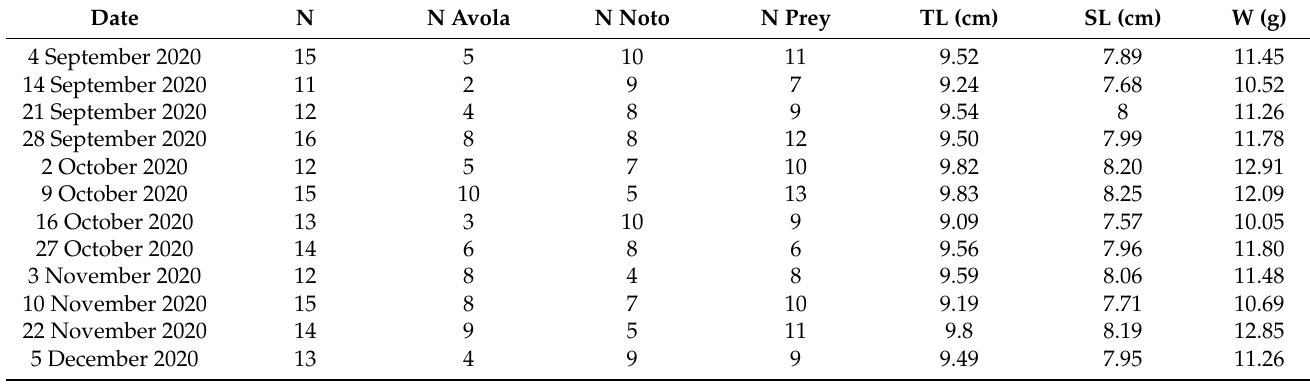
Table 1. Means of the basic measurements per sampling day for Gobius paganellus ; N = total number of specimens; N Avola = specimens collected at Avola; N Noto = specimens collected at Noto; N Prey = specimens with at least one prey in their stomach; TL = total length; SL = standard length; W =